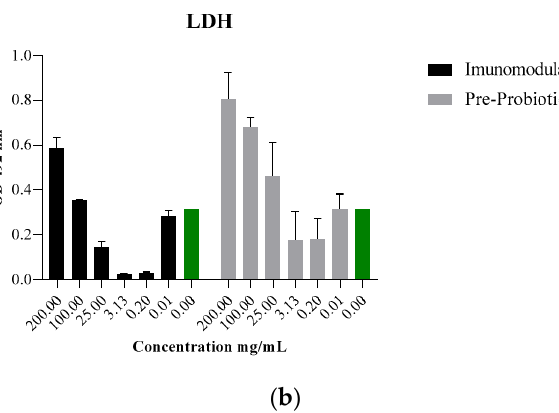
Figure 2. ( a ) MTT and ( b ) LDH assessment of novel nutraceuticals on L929 murine fibroblasts.